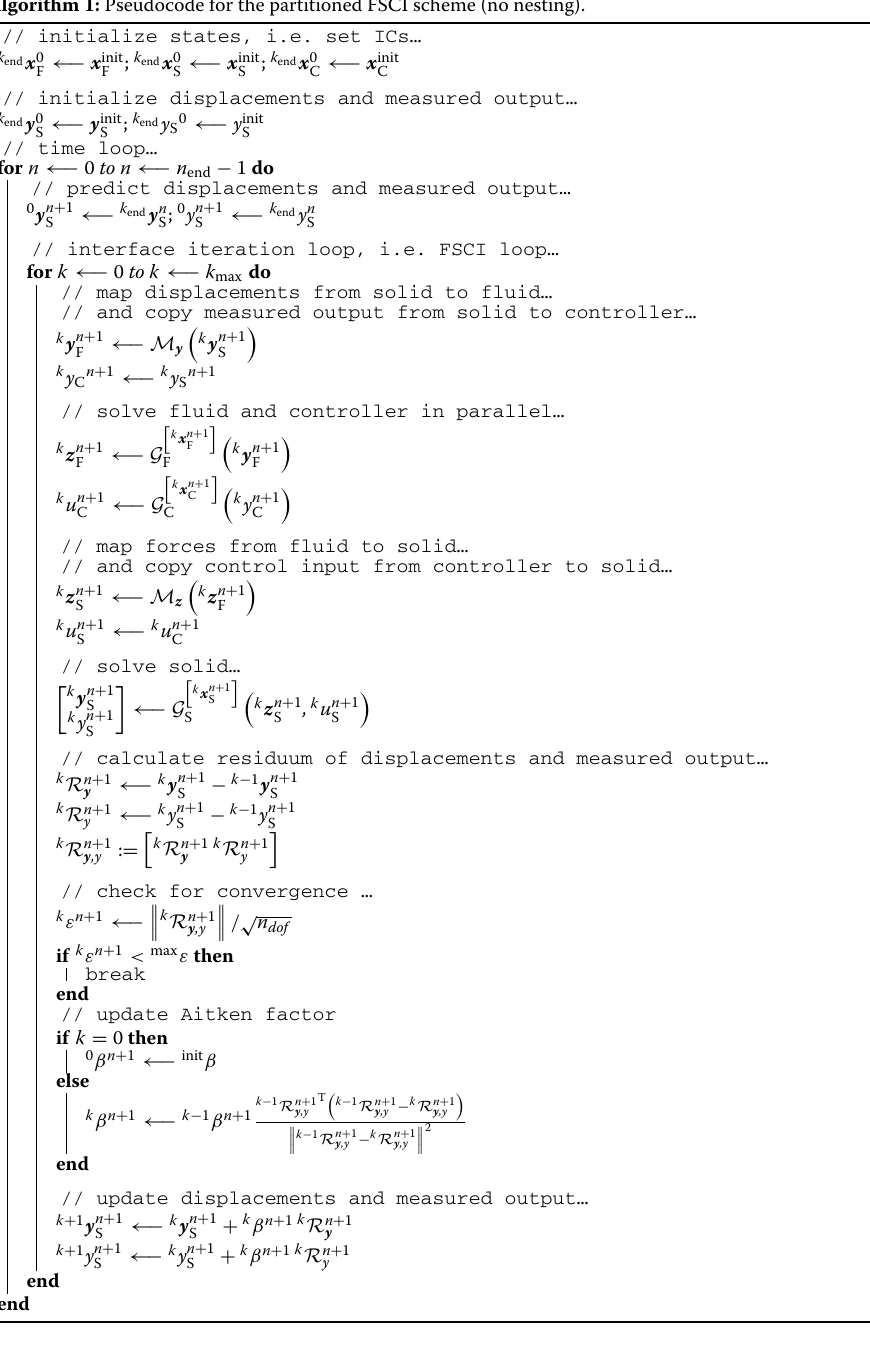
Algorithm 1: Pseudocode for the partitioned FSCI scheme (no